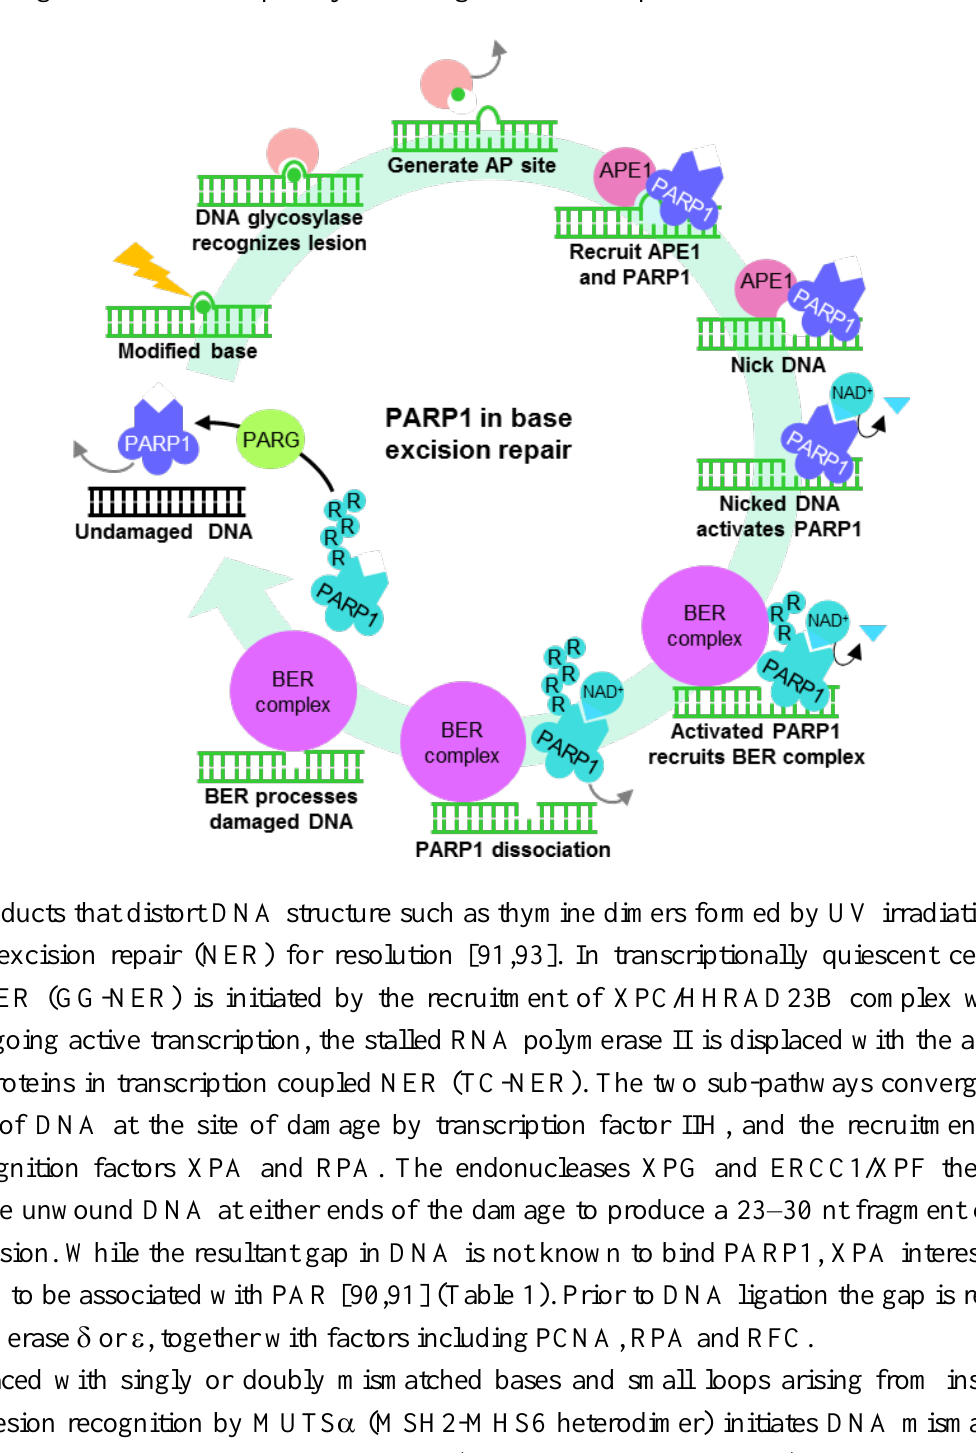
Figure 2. The role of PARP1 in base excision repair (BER). PARP1 may also mediate DNA single-strand break repair by recruiting the BER